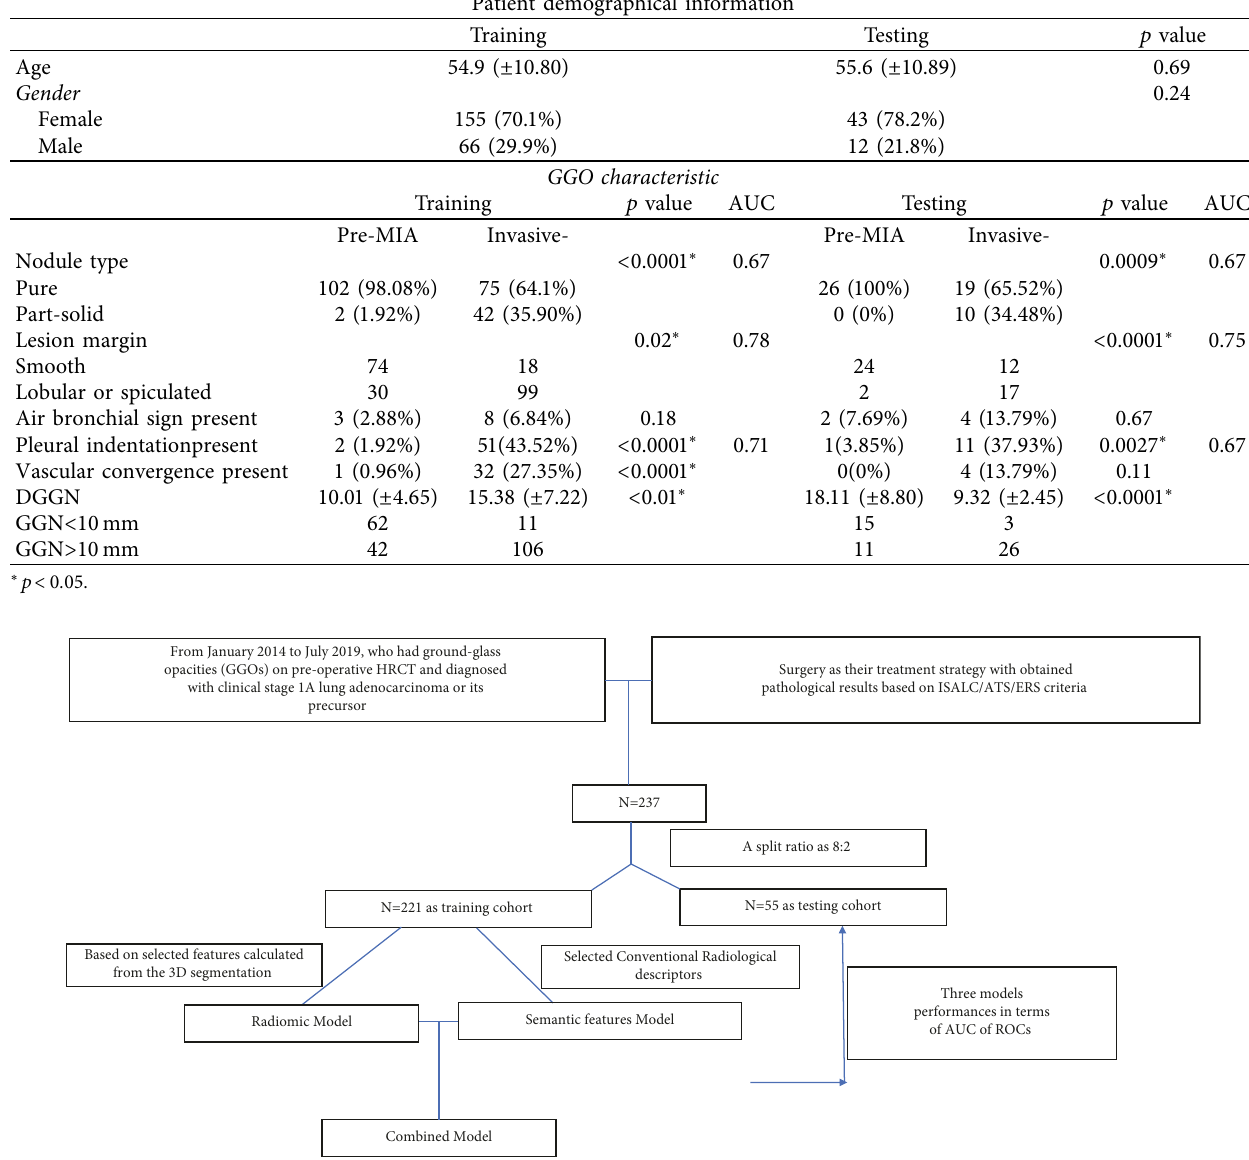
Figure 2: Nodules on HRCT enrolment of modeling.